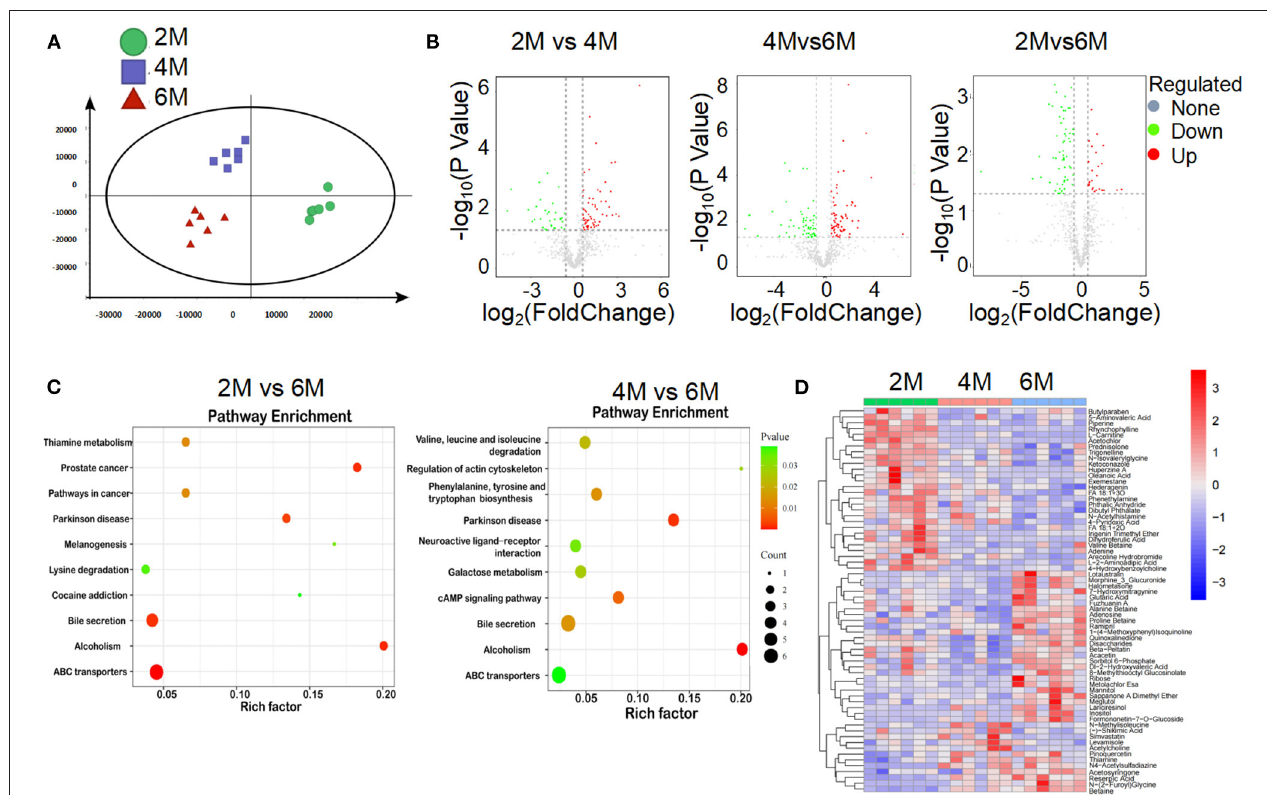
FIGURE 4 | Alteration of gut microbial-associated metabolites in feces of 2-, 4-, and 6-month-old K14-VEGF mice. (A) Partial least squares discriminant analysis (PLS-DA) of the fecal metabolites from 2-, 4-, and 6-month-old K14-VEGF mice ( n = 6 per group). (B) Volcano plots of differential gene expression: 2 vs. 4 months, 4 vs. 6 months, and 2 vs. 6 months. (C) Enriched KEGG pathways in fecal metabolites of 2 vs. 6 months and 4 vs. 6 months were shown with the P -values and the number of metabolites represented in each pathway. The size of each bubble represented the number of metabolites differentially expressed in each pathway, with a scale on the lower right. (D) Heat map of differentially expressed fecal metabolites among 2-, 4-, and 6-month-old K14-VEGF mice. Each column represented one mouse. The 2-, 4-, and 6-month-old K14-VEGF mice were depicted in green, red, and blue,